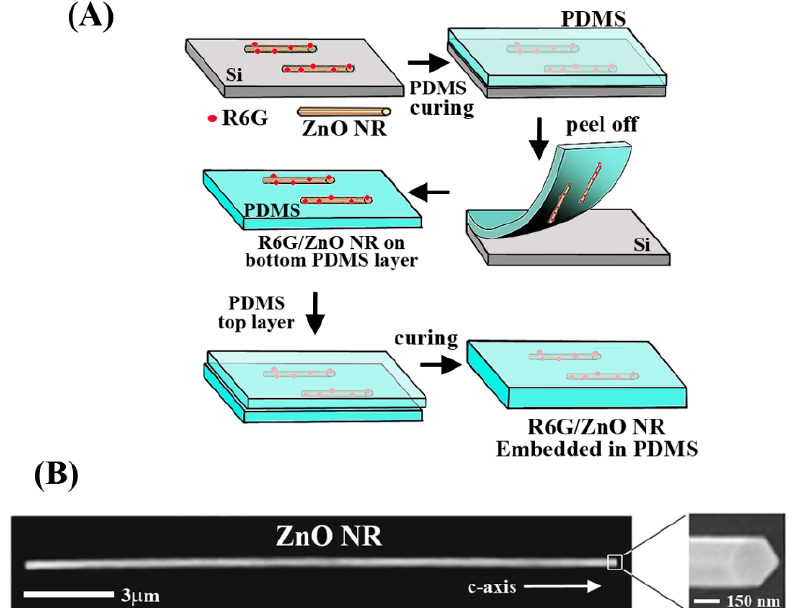
Figure 1. ( A ) The scheme illustrates the overall sample fabrication process for constructing R6G- coupled ZnO NRs embedded in a PDMS elastomer piece. ( B ) The SEM image displays representative ZnO NRs used in our experiments. The high shape anisotropy and crystalline features of as-grown ZnO NRs are apparent along the c-axis, as shown in the SEM image. The zoomed-in SEM panel displays the hexagonal basal facets of the NR ends and its rectangular prismic facets on its main body.